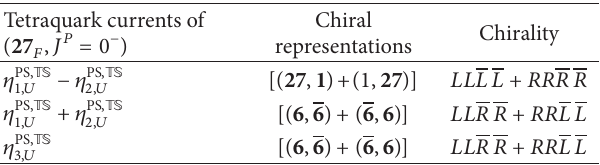
Table 7: Flavor 27 𝐹 tetraquark currents of 𝐽 𝑃 = 0 − classified